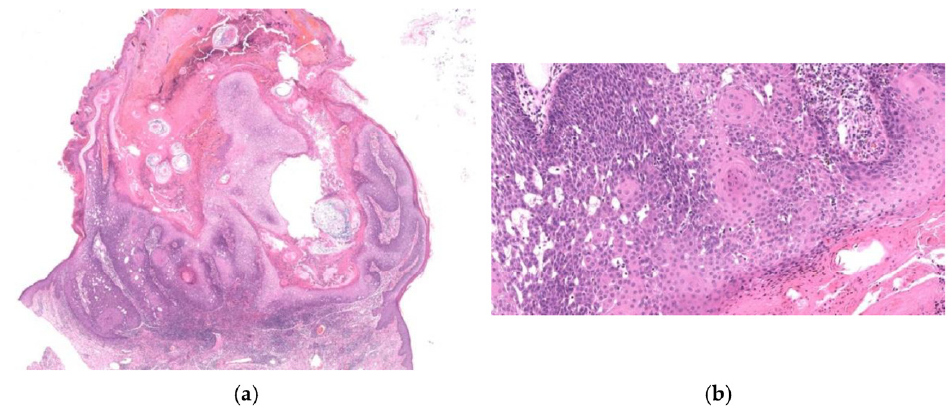
Figure 9. Histopathological findings of CSK. The lesion is crateriform with finger-like exophytic projections ( a ), showing hyperkeratosis and acanthosis with proliferation of basaloid cells ( b ). Pseu- dohorn cysts ( a ) and squamous eddies ( b ) are evident.